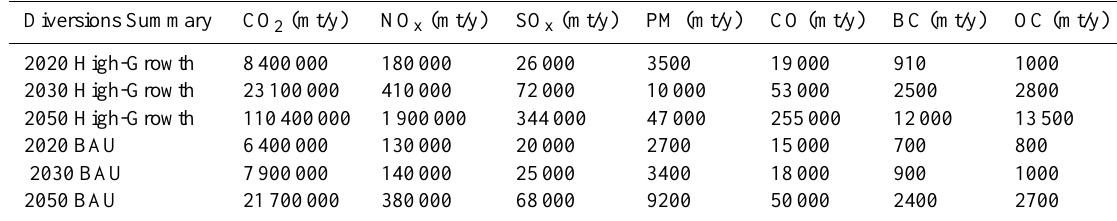
Table 10. Summary of potential emission inventories from diverted global shipping to Arctic routes.